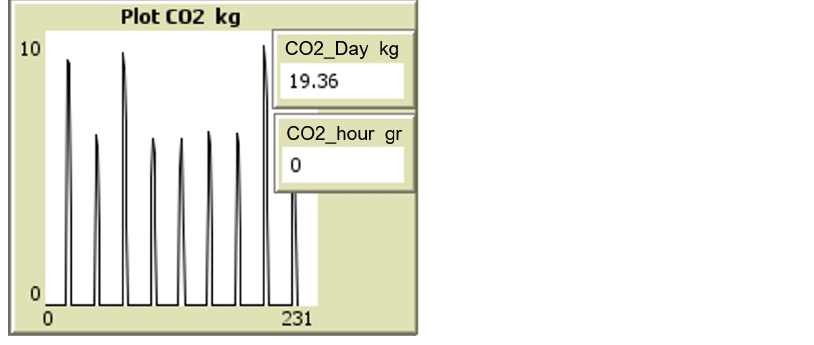
Figure 17. Graph and indicators of carbon dioxide generation, implemented in Netlogo.